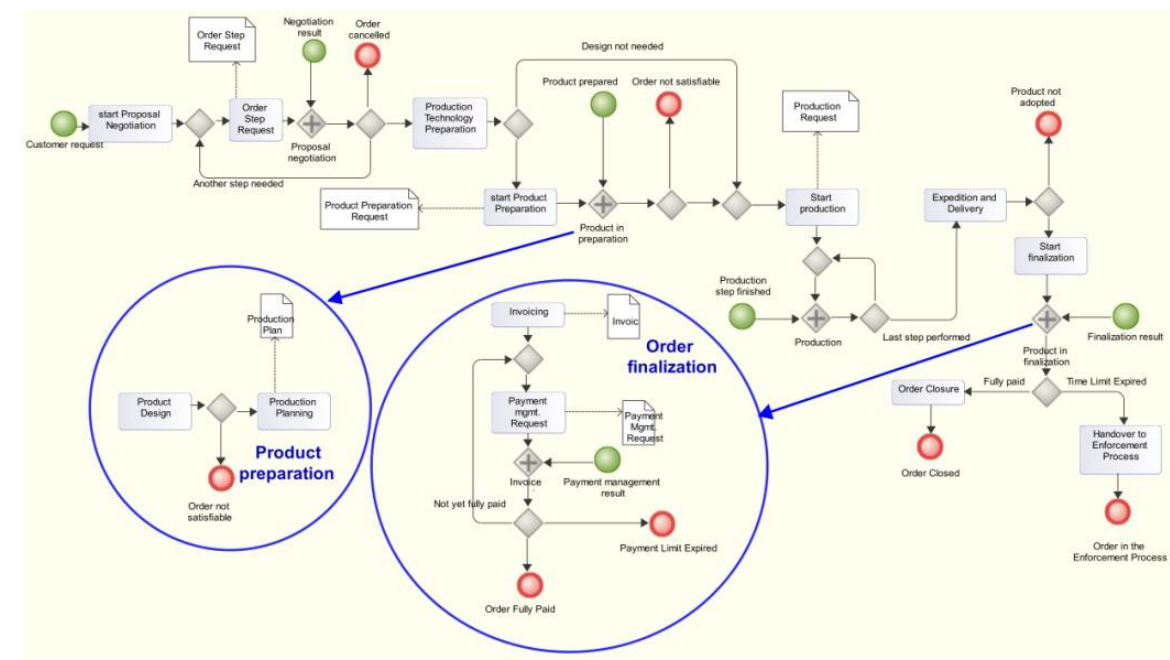
Figure 5 . Example – Process in the 2nd and 3rd Normal Forms